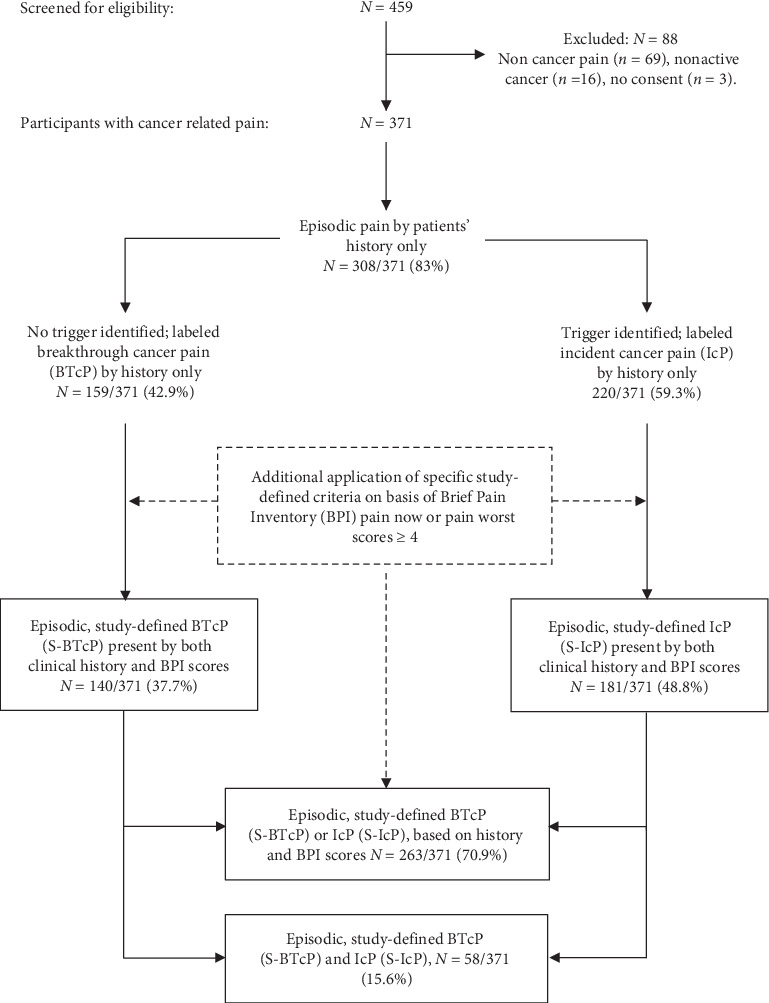
Study flow diagram.